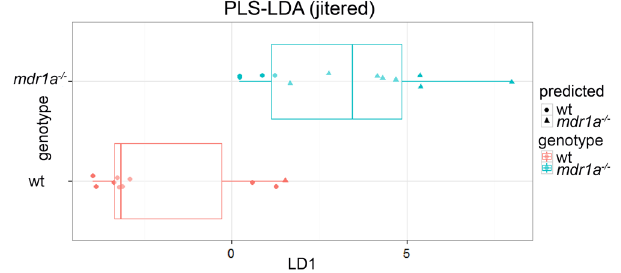
Figure 4. Partial least squares-linear discriminant analysis (PLS-LDA) discriminates urinary metabolite profiles from mdr1a − / − and WT mice based on genotype. Boxplot of genotype predictions for WT and mdr1a − / − mice, where the central rectangle spans the first quartile to the third quartile with median shown as a line; whiskers above and below the box represent the maximum and minimum respectively. True mdr1a − / − are in blue, predicted mdr1a − / − are triangles; true WT are in red, predicted WT are in circles. Therefore, blue circles are false negatives and red triangles are false